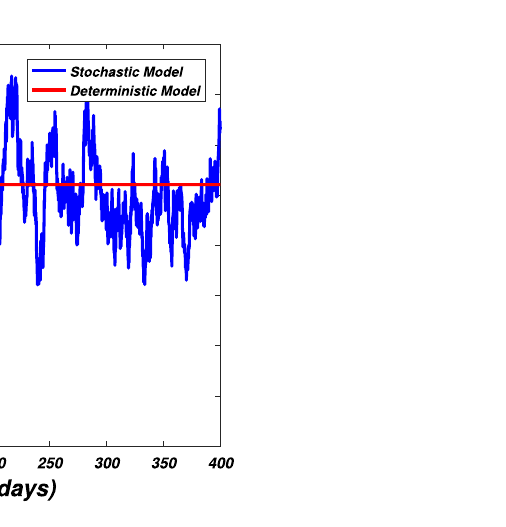
Figure 8. The graph visualizes the temporal dynamics of the model under consideration (1) in the long run for the recovered class ( r ( t )) against the parametric value taken from S 1 and initial classes (0.5, 0.3, 0.2,